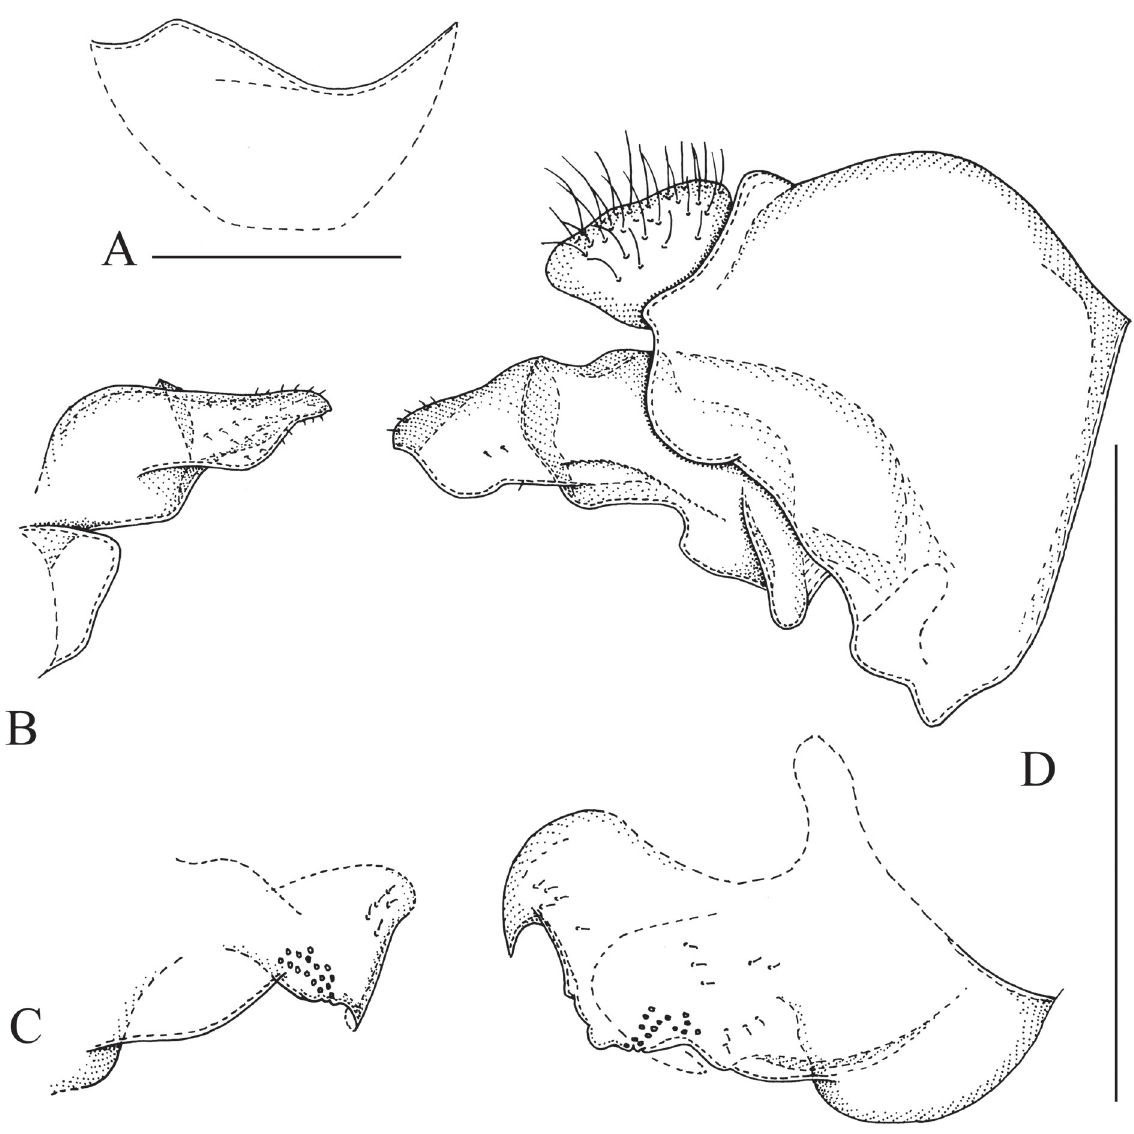
Fig. 64. Sphegina (As iosphegina) nubicola sp. nov., holotype, ♂ . A . Sternum IV, ventral view. B . Left surstylus, lateral view. C . Left superior lobe with associated parts, lateral view. D . Genitalia, right side, lateral view. Scale bars = 0.5